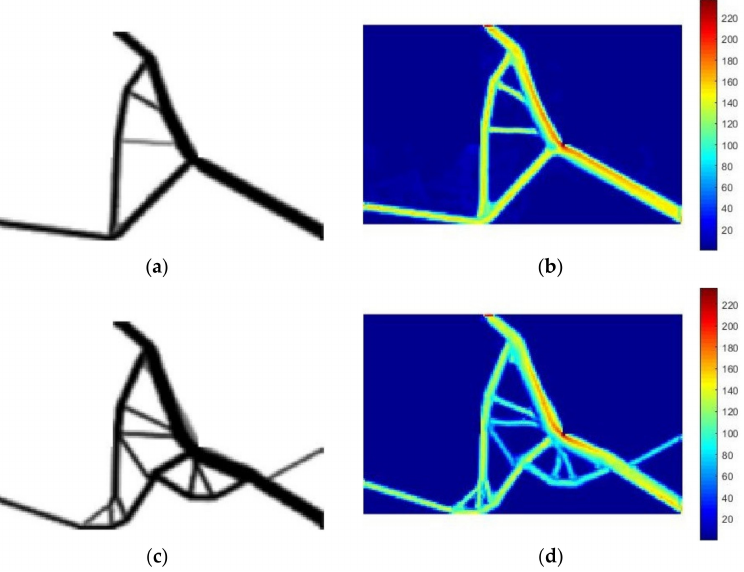
Figure 15. Topology optimization results of T-beam ( ∆ T = 30 ◦ C): ( a ) DTO topological structure; ( b ) DTO Von Mises stress distribution; ( c ) RBTO topological structure; ( d ) RBTO Von Mises stress